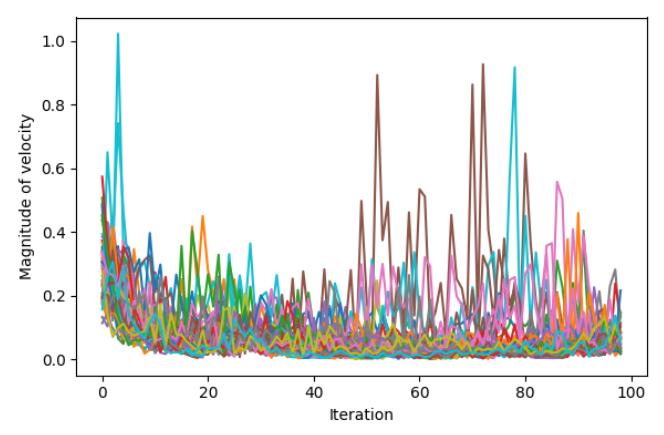
Figure 7. Velocity magnitudes for each of the particle position updates throughout the optimisation process using the BLSK-NS weight inheritance